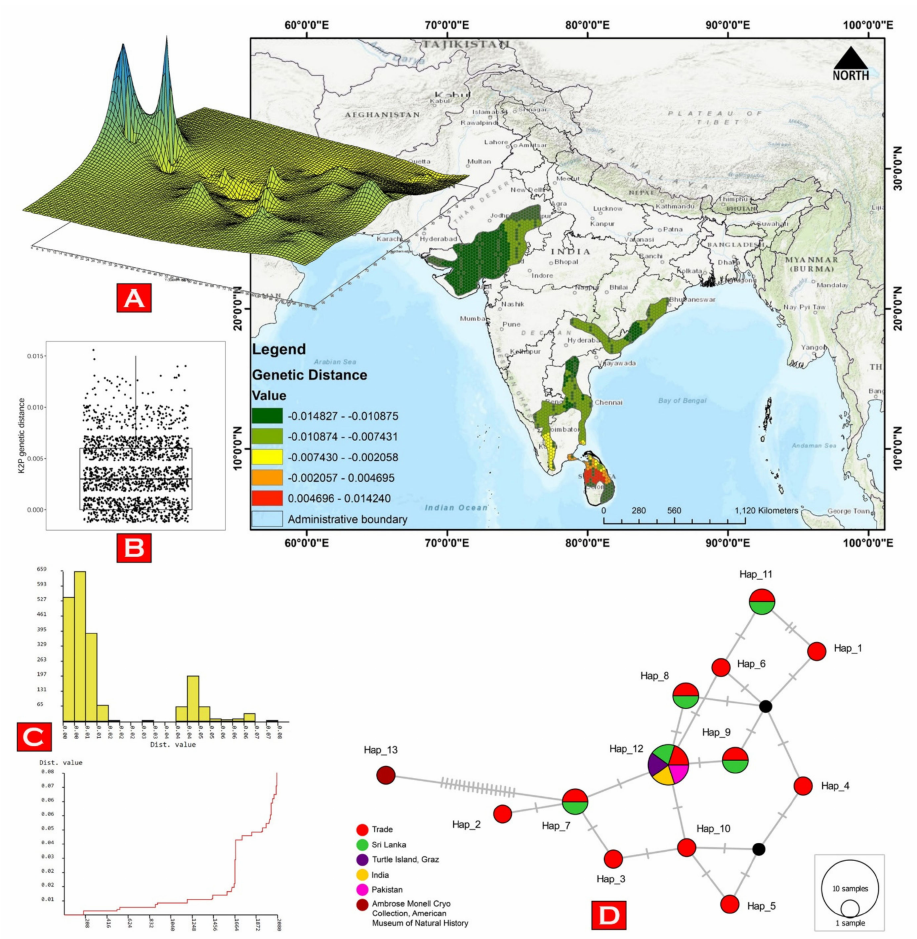
Figure 2. ( A ) Results of the genetic landscape shape interpolation analysis of G. elegans with the distance weight parameter α = 1, projected on a grid size of 1 × 1 degree. The high values denote high, and low values denote low, genetic diversity corresponding to their locality information; ( B ) a box plot showing the weak intra-species genetic distance; ( C ) the ABGD web interface of the present dataset showing a histogram and ranked distances; and ( D ) a TCS haplotypic network showing the relationship among all the haplotypes of G. elegans . Circle sizes are proportional to the number of individuals that belong to each haplotype, and mutational steps are symbolized by dashes. The median vectors (hypothetical haplotypes) are denoted by black